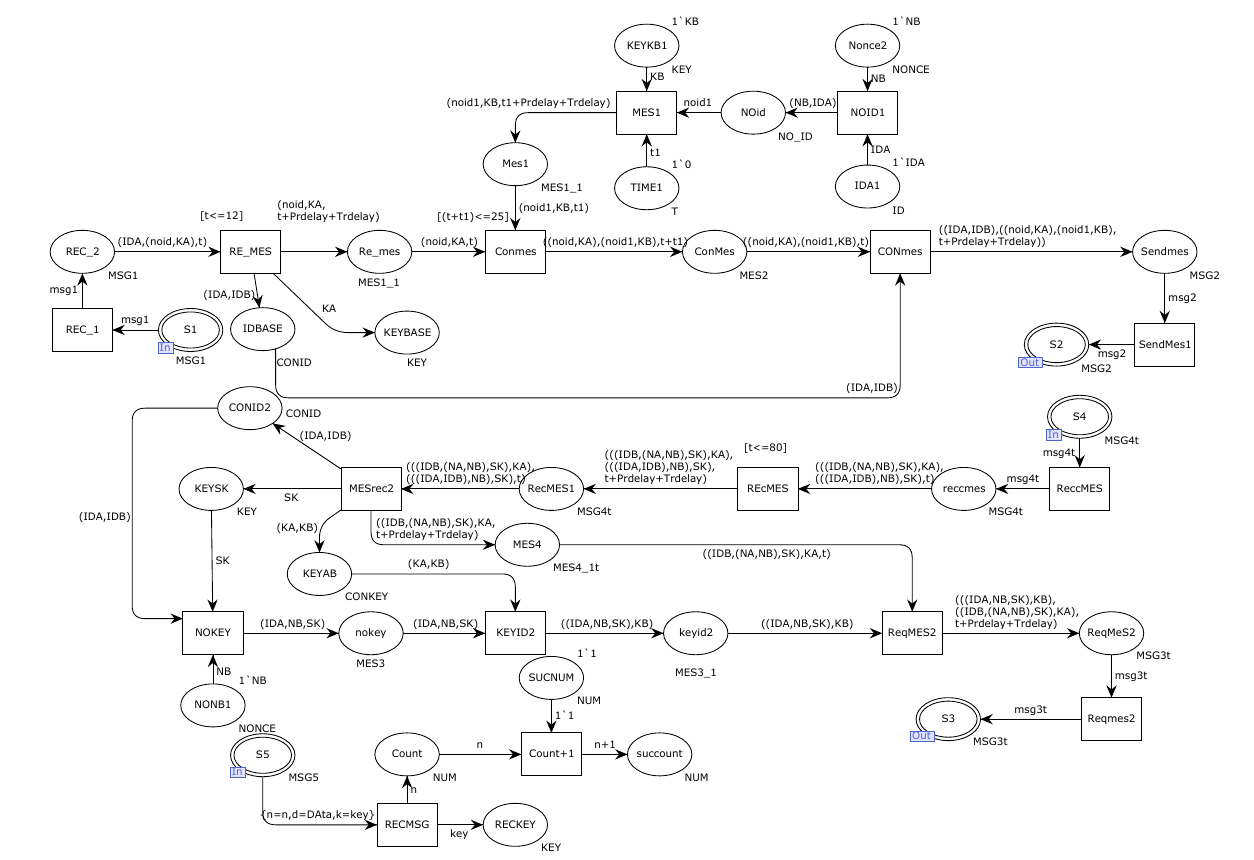
Figure 12. Internal model of the improved solution